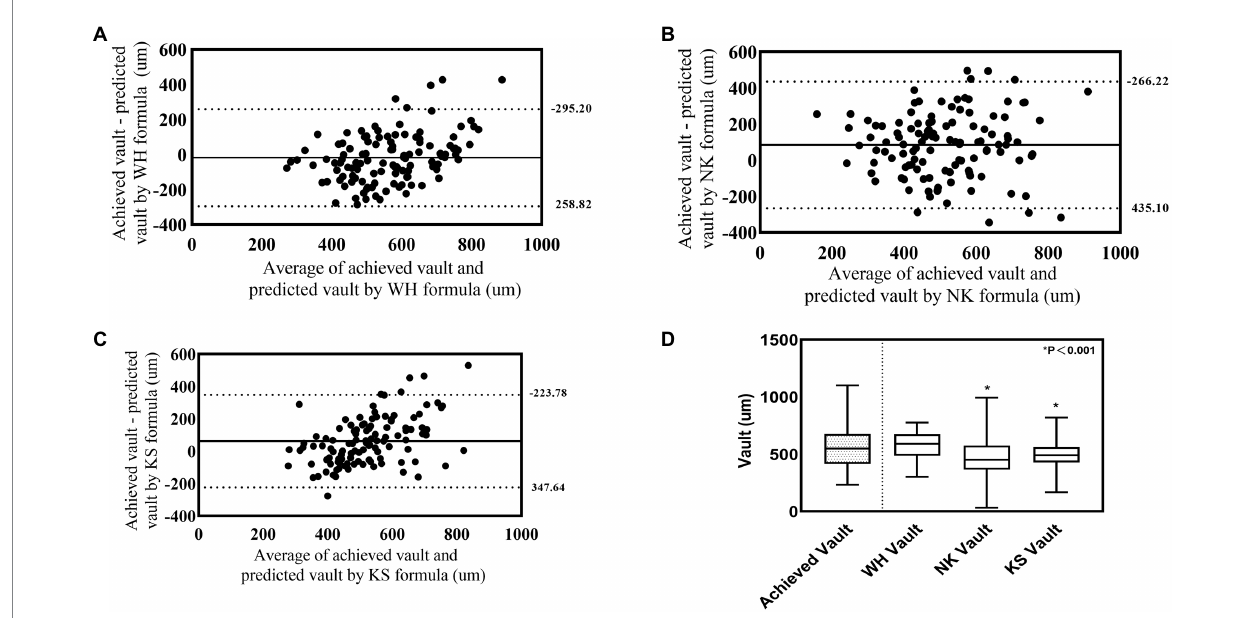
FIGURE 4 Comparison between achieved vault and model predicted Vault in the validation group. (A) Bland-Alterman plot of achieved vault versus WH formula predicted vault. (B) Bland-Alterman plot of achieved vault versus NK formula predicted vault. (C) Bland-Alterman plot of achieved vault versus KS formula predicted vault. The solid line represents the mean difference between achieved vault and predicted vault dotted lines are the upper and lower borders of the 95% LoA (mean difference ± 1.96 multiplied by standard deviation of the mean difference). (D) Box plot of achieved and predicted vault by WH formula, NK formula and KS